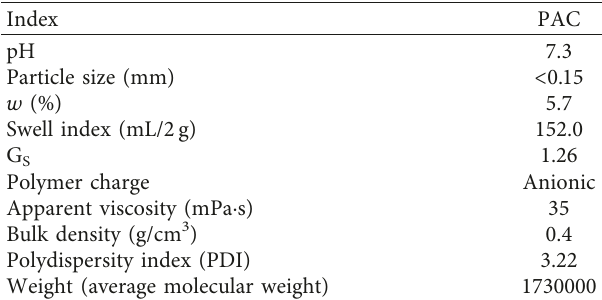
Table 3: Properties of polymer used in this study (data from the manufacturer).